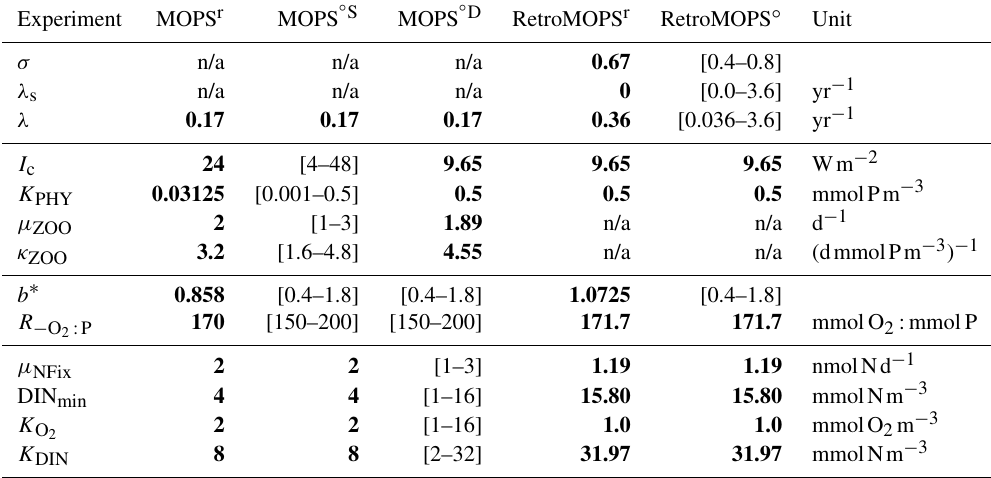
Table 1. Experimental set-up of optimisation. Parameters that stay fixed are highlighted. For parameters subject to optimisation we indicate the assigned a priori lower and upper parameter boundary (parameter range, R A this